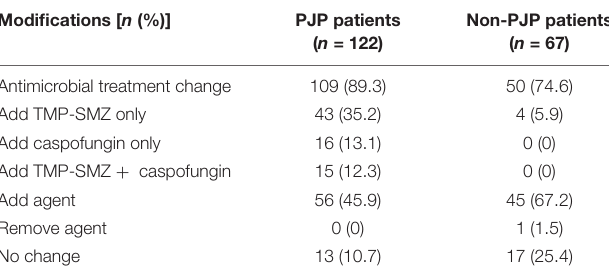
TABLE 3 | Impact of mNGS on antimicrobial treatment for patients with PJP. Modifications [ n